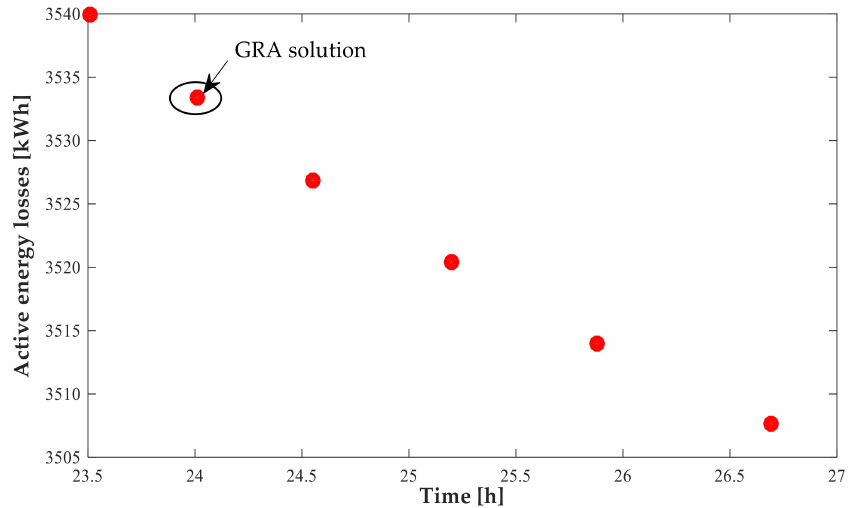
Figure 13. Pareto front optimal solutions.